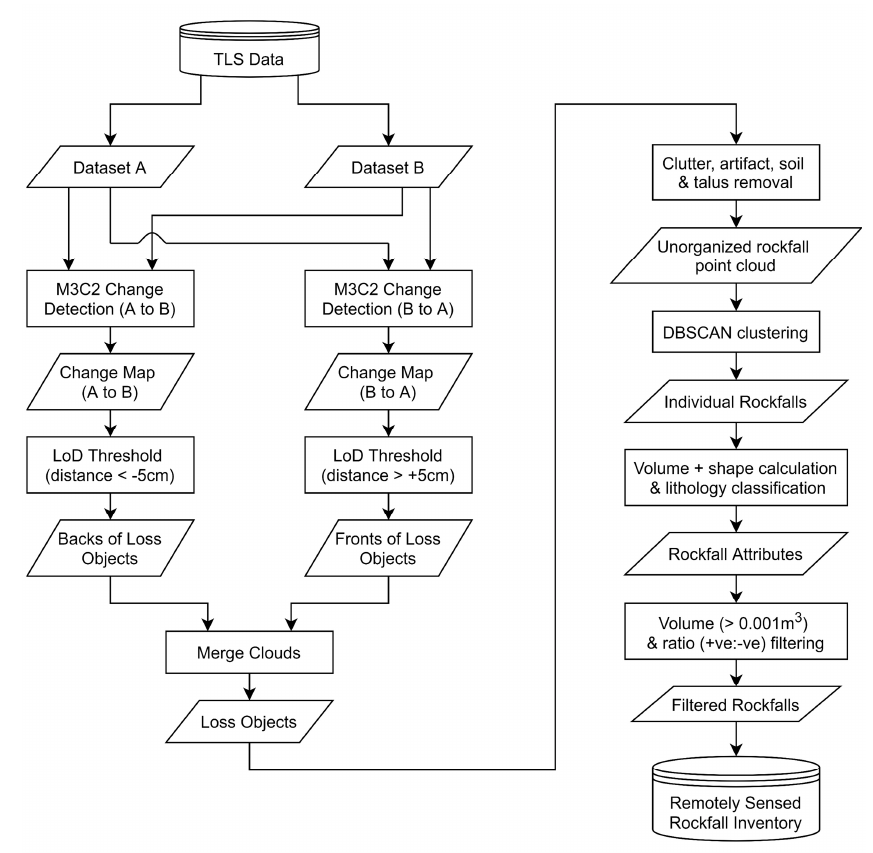
Figure 7. Flow chart of the semi-automated rockfall extraction process.